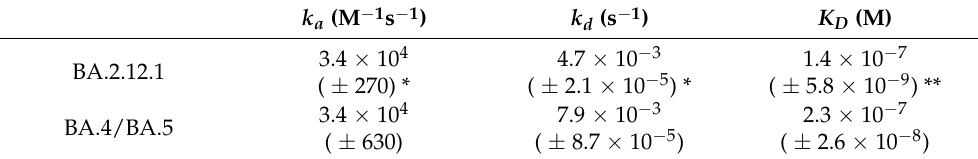
tions. ** Standard deviation (SD) on triplicated experiments.